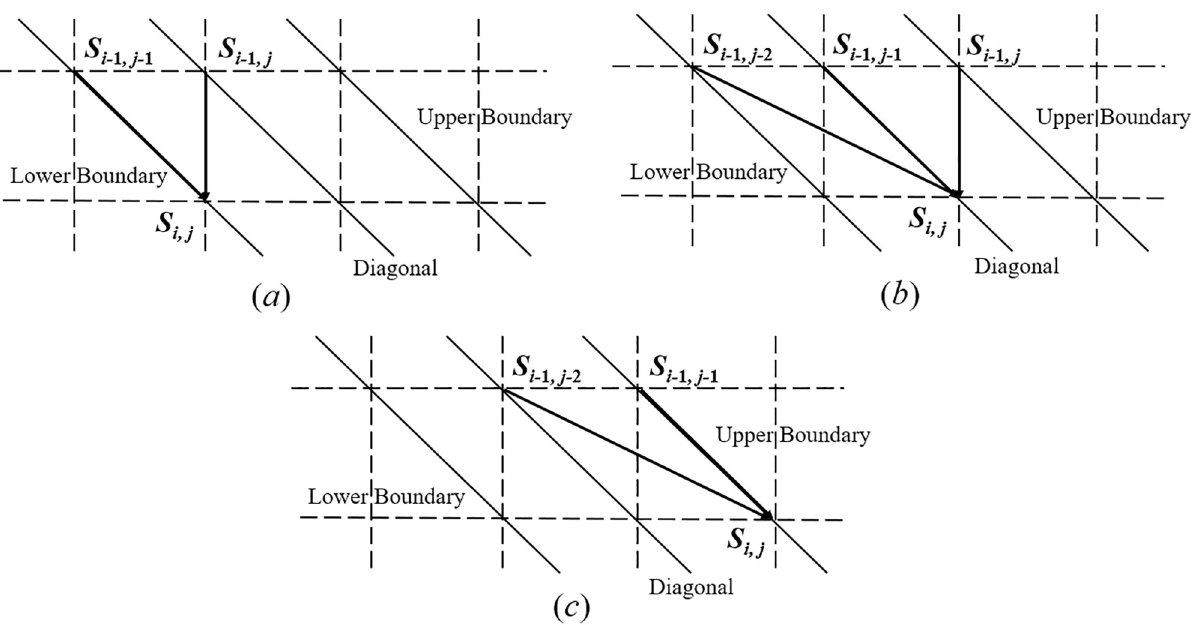
Fig 5. Possible state transitions when x k is transmitted on condition that S i , j occurs. (a) S i , j is located on the lower boundary ( i − j = 1); (b) S i , j is located on the diagonal ( i − j = 0); (c) S is located on the upper boundary ( j − i = i , j